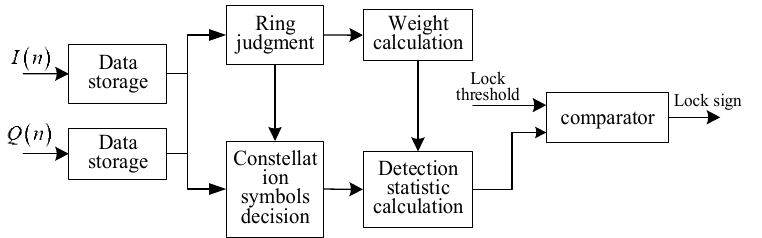
Figure 1. Block diagram of carrier synchronization lock detection method based on the weighted detection statistic for APSK signals.